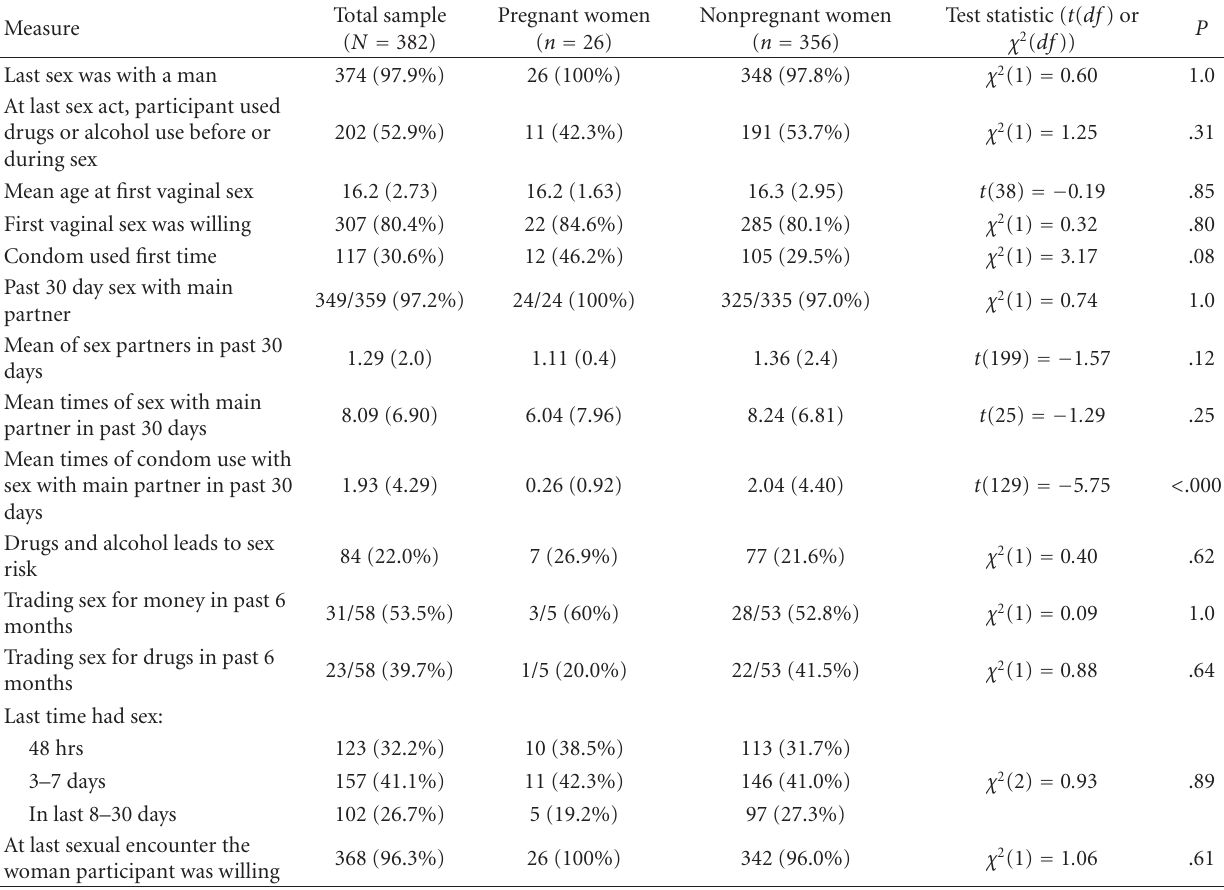
Table 2: Sexual behavior of pregnant and nonpregnant women ( N =